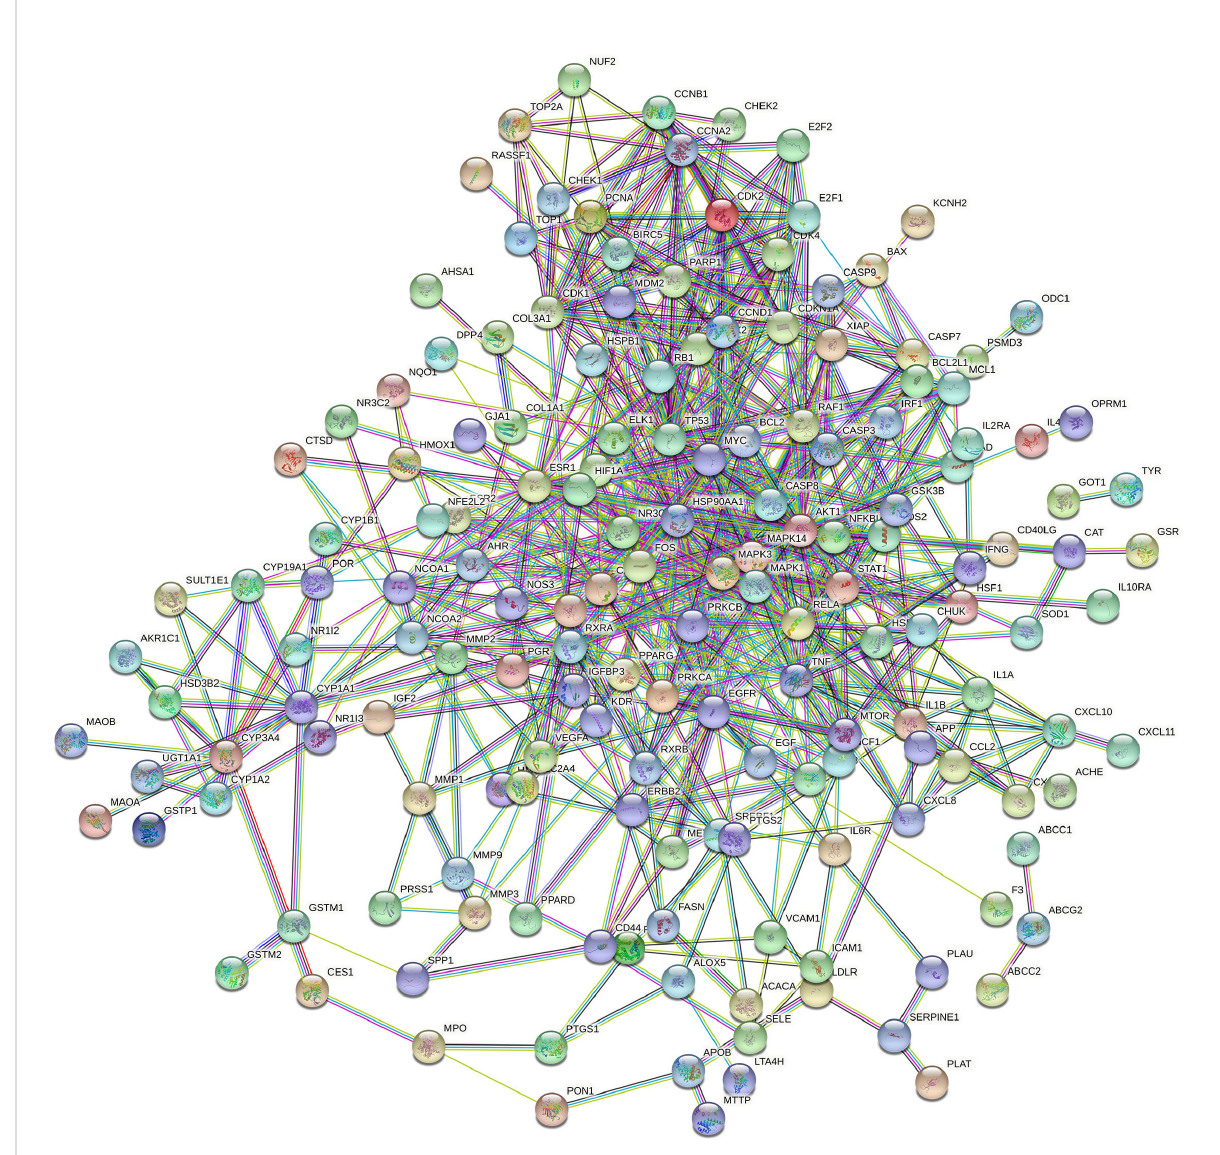
FIGURE 6 The network for 196 co-targeted genes/proteins had been selected as input for PPI analysis in